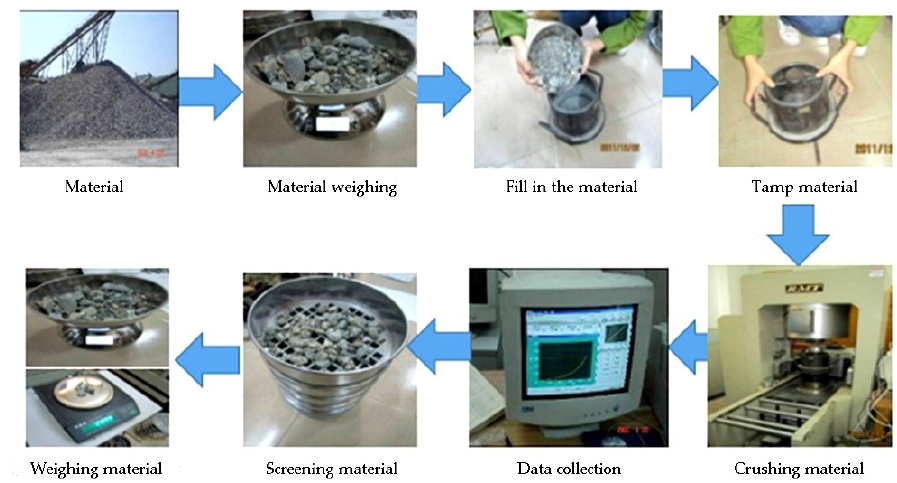
Figure 1. Experimental processes of rock material interpartical breakage.